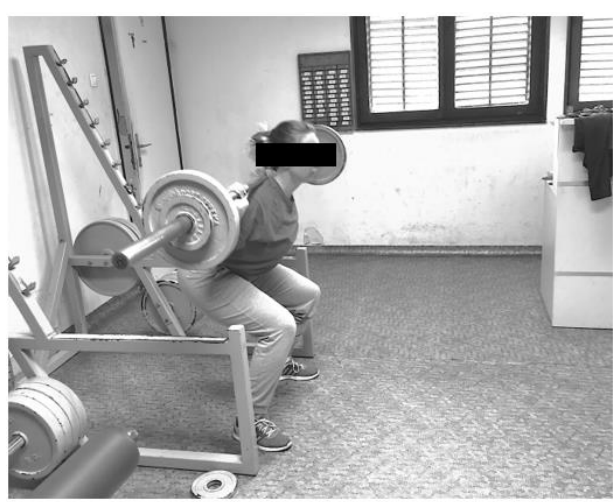
Figure A1. A photo of participants training squats.